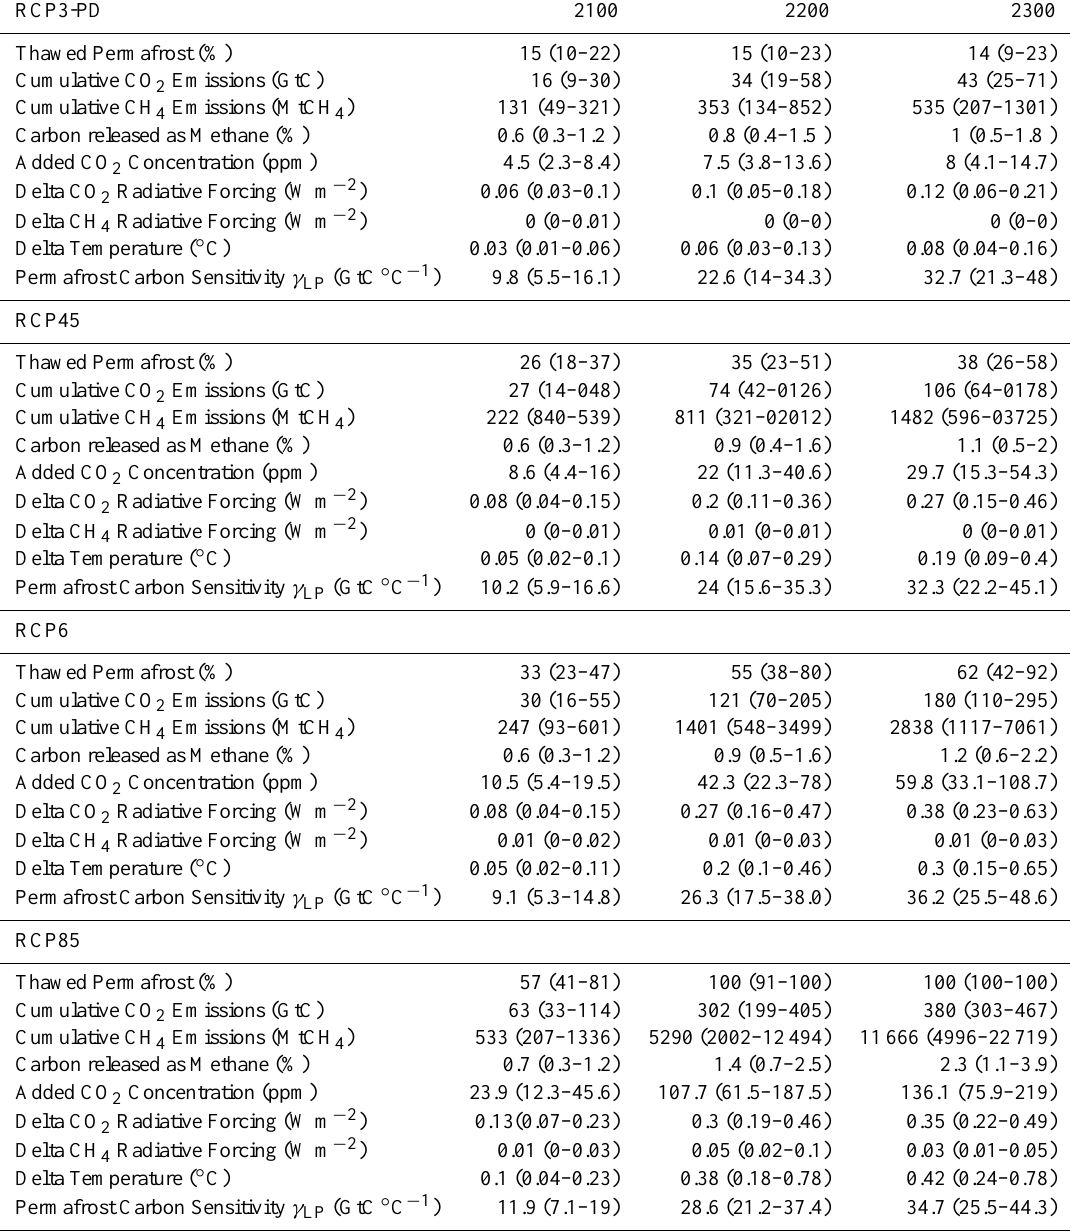
Table 2. Median (68%-range) estimates of permafrost characteristics under the four RCPs in year 2100, 2200 and 2300. The thawed permafrost area is provided, weighted in relation to the initial carbon pool distribution. Cumulative emissions of CO 2 , CH 4 (without contributions of carbon in the slow pool) and the share of carbon that is released as methane are shown for cumulative emissions from pre-industrial times until the indicated year. Subsequent rows indicate additional CO 2 concentrations, CO 2 radiative forcing, CH 4 radiative forcing and global mean temperatures due to permafrost thawing above the background scenario. The permafrost carbon sensitivity LP indicates the change in the permafrost carbon stock until that year, given relative to that year’s global mean surface